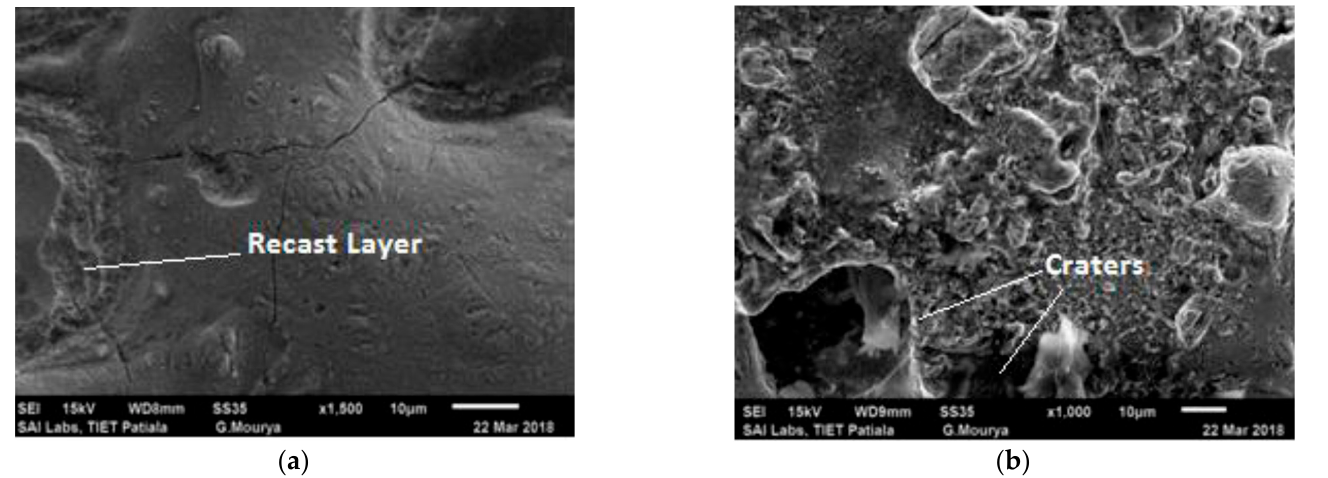
Figure 5. Surface characteristics of a workpiece after EDM ( a ) for Experiment 10 and ( b ) for Experiment 19.